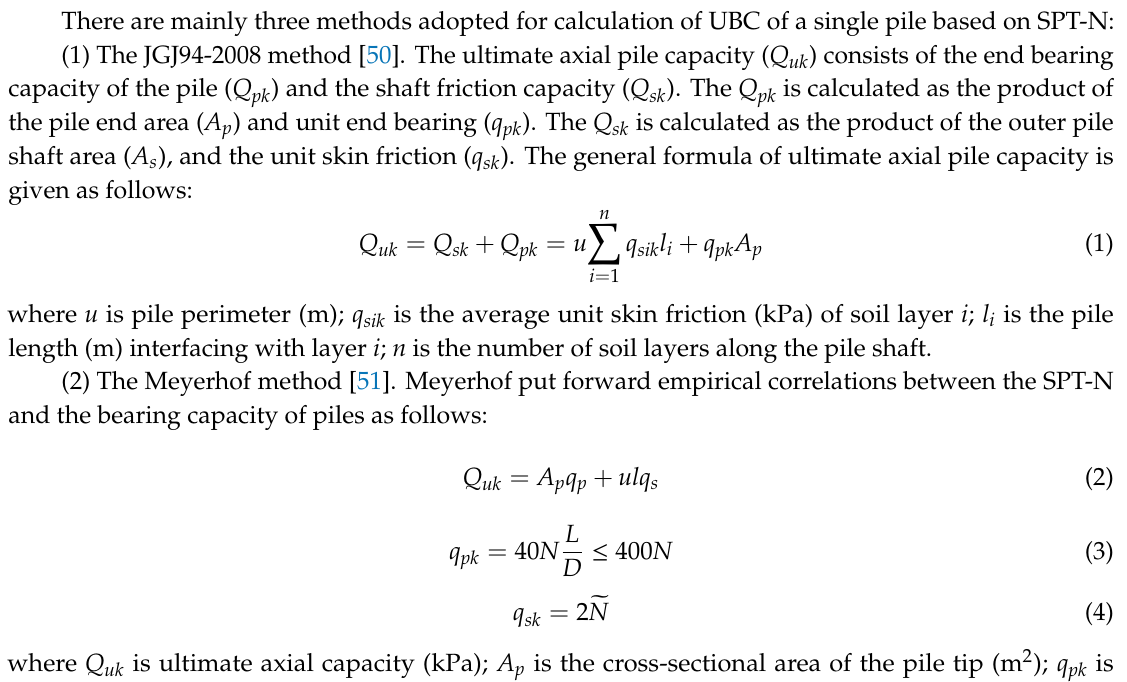
Figure 2. ( a ) Schematic of penetrator; ( b ) Bentonite mud preparation; ( c ) standard penetration test (SPT) testing.